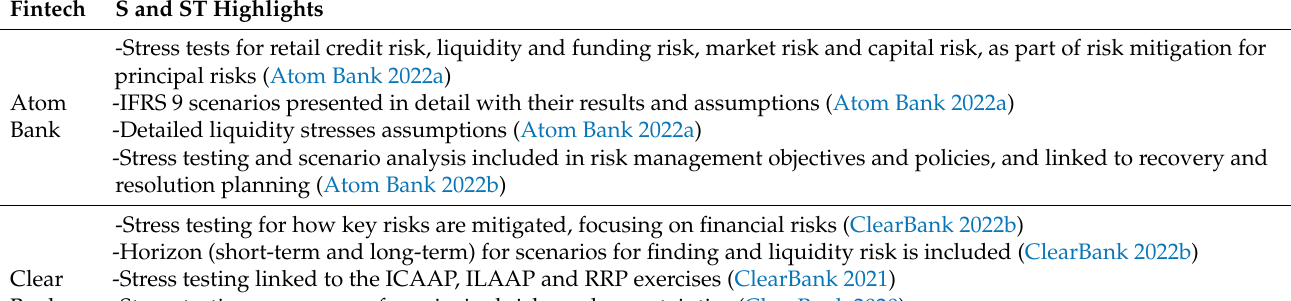
Table 4. Empirical Analysis—Fintech Disclosures: S and